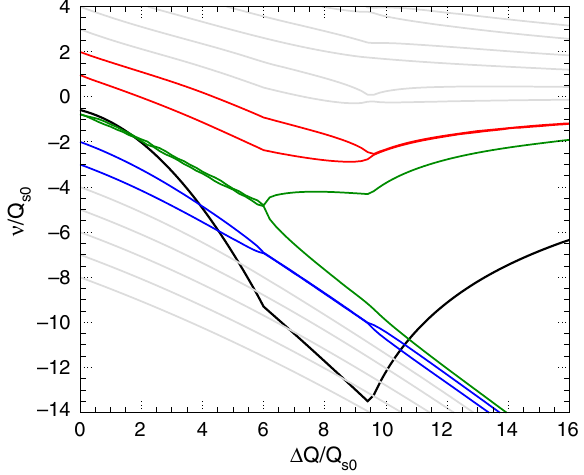
¼ 8 . The solid black FIG. 1. The TMCI threshold of the hollow bunch in the square FIG. 2. Threshold bunch spectrum at N max potential well against the SC tune shift. Different curves are line is the TMCI threshold in this approximation. Other lines ¼ 1 ; … 19 . Each of them has a obtained with different N present the bunch eigentunes just before the instability appears. max Coalescence of different multipoles is responsible for the insta- restricted region of applicability which expands with N max bility at different Δ Q=Q growing. The drop-down parts of the curves merge forming . The essential lines are emphasized by s 0 the sole black line. The rising lines do not confirm each other colors. marking ends of the applicability regions.